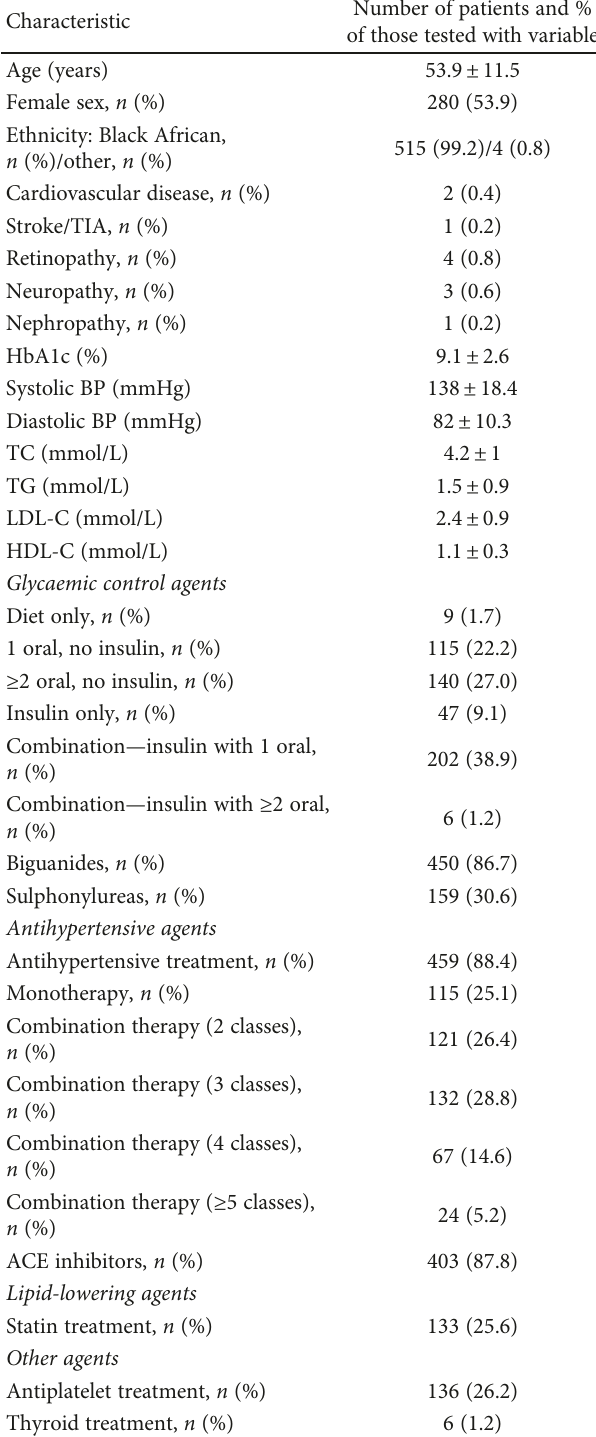
Table 1: Clinical characteristics: patients with T2DM attending the Hillbrow Community Health Centre.